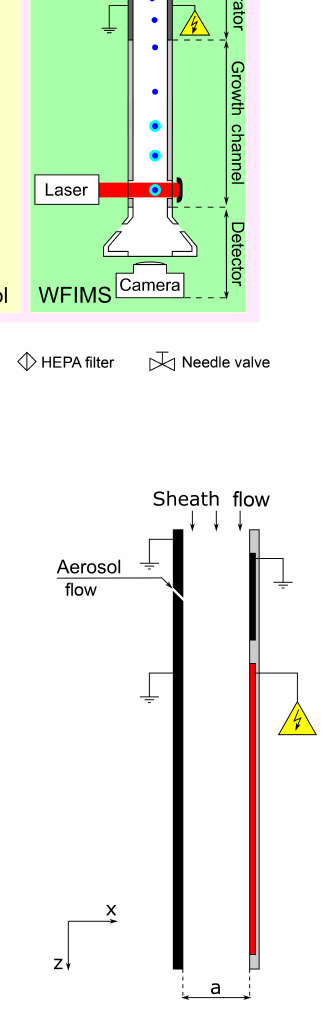
Figure 2. Schematic diagram of the offset electrode used in the HFIMS with the aerosol inlet on the